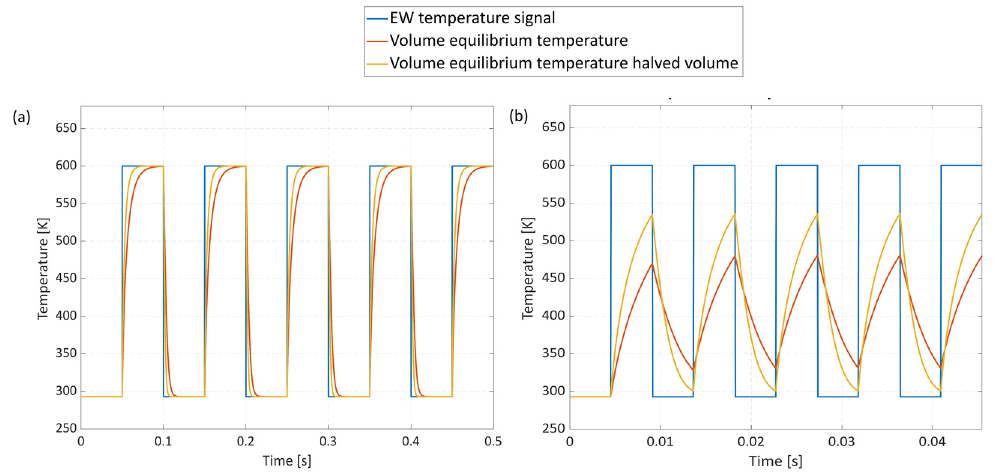
Figure 11. Simulation of hot–cold mixing at different frequencies: ( a ) 10 Hz and ( b ) 110 Hz.